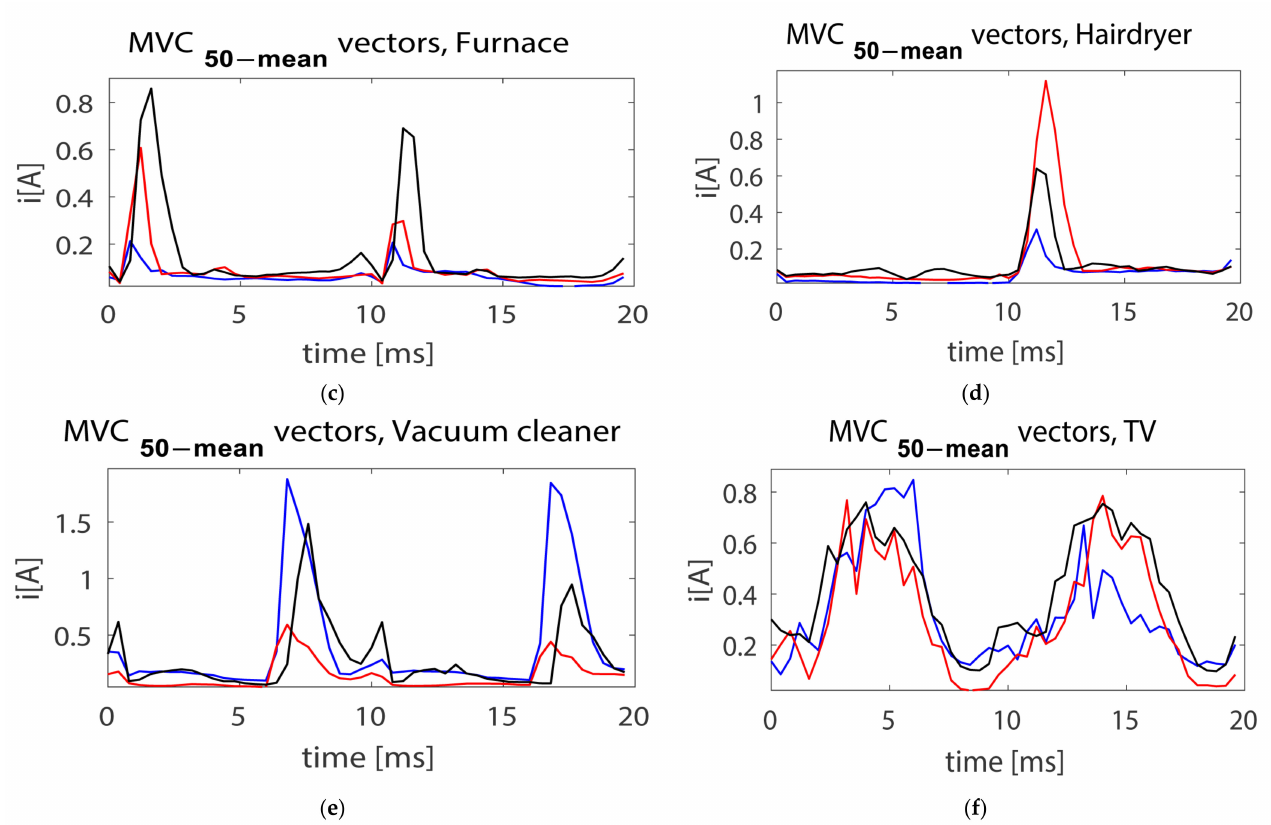
Figure 11. Examples of MVC 50 − mean vectors for the occurrence of series arc on-line with particular tested appliances for a different number of devices operating simultaneously (blue line—one device, red line—two devices, black line—three devices) ( a ) computer, ( b ) bulb, ( c ) furnace, ( d ) hairdryer ( e ) vacuum cleaner, ( f )